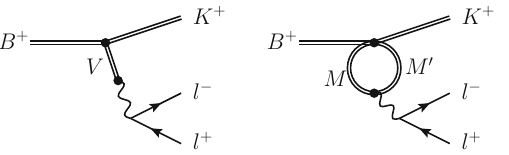
Fig. 1 Diagrammatic representations of the long-distance contribu- μ, eff tions to C